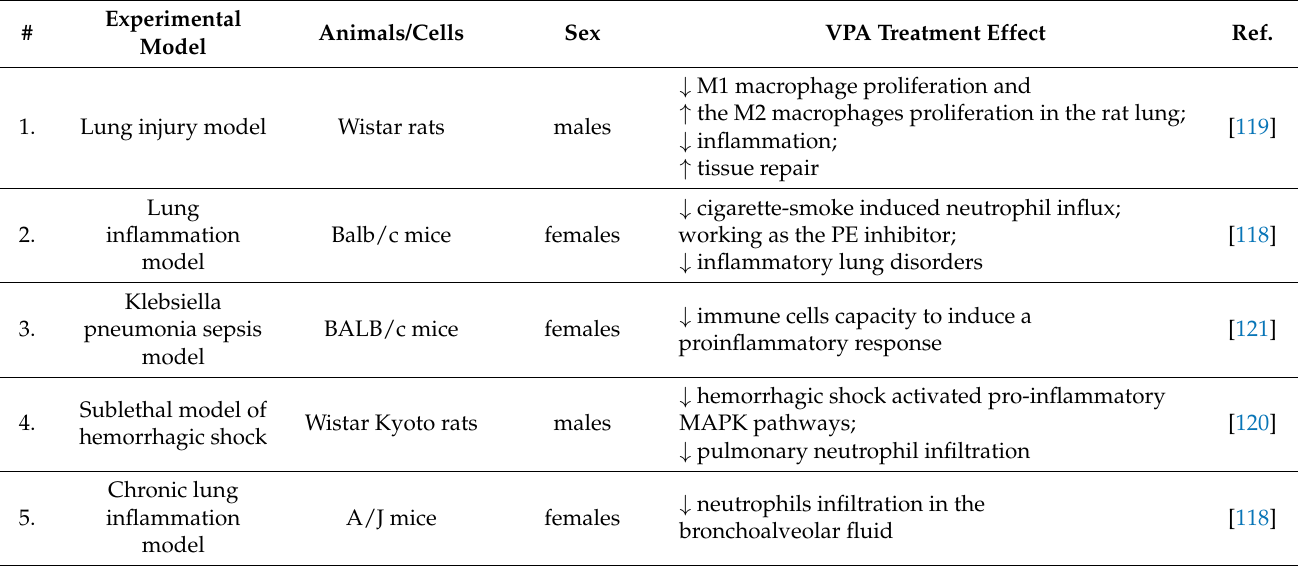
Table 1. Experimental studies of VPA treatment effectiveness on immune-inflammation in vivo and in